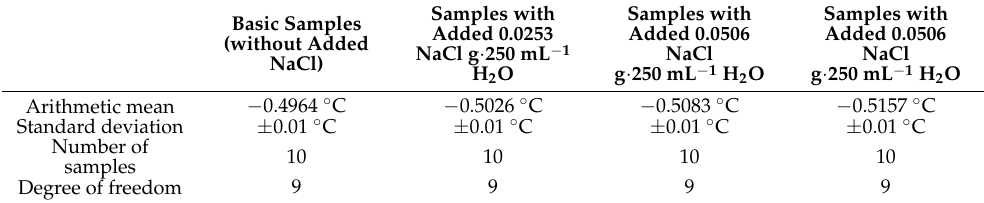
Table 2. Analysis of variance of freezing temperature ( ◦ C) of raw cow’s milk.